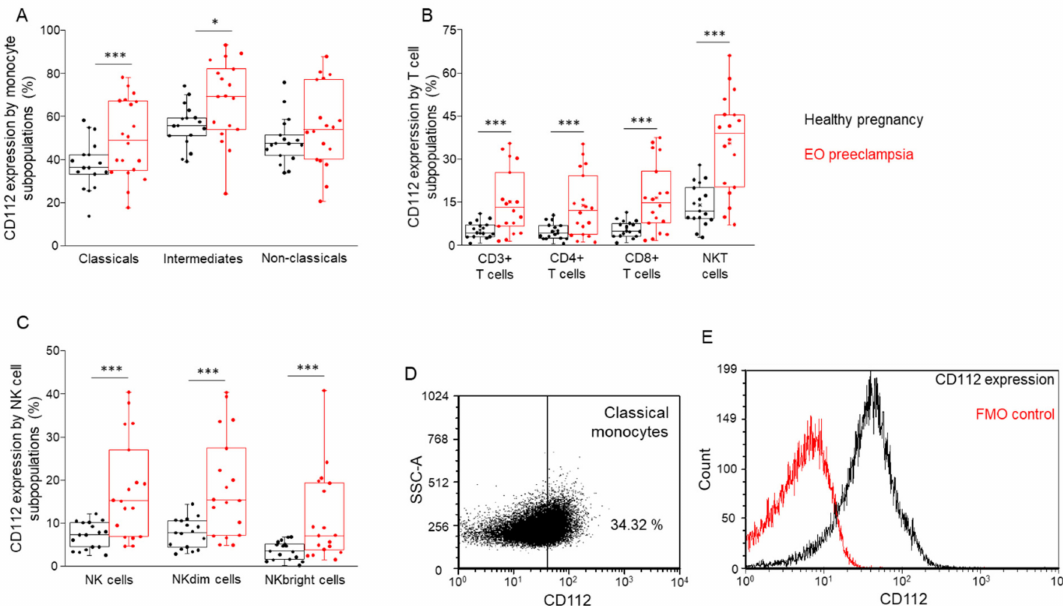
Figure 8. CD112 expression by the investigated immune cell subpopulations in women with EO preeclampsia and healthy pregnant women. The expression of CD112 by different monocyte ( A ), T cell ( B ), and NK cell ( C ) subpopulations in the peripheral blood of women with EO preeclampsia and healthy pregnant women. The solid bars represent medians of 17 and 20 determinations, respectively, the boxes indicate the interquartile ranges, and the lines show the most extreme observations. Differences were considered statistically significant for p -values < 0.05 *, p < 0.01 ***. Representative FACS plots show the expression of CD112 receptors by classical monocytes ( D ). To determine the positivity of the CD112 receptor, FMO control was used ( E